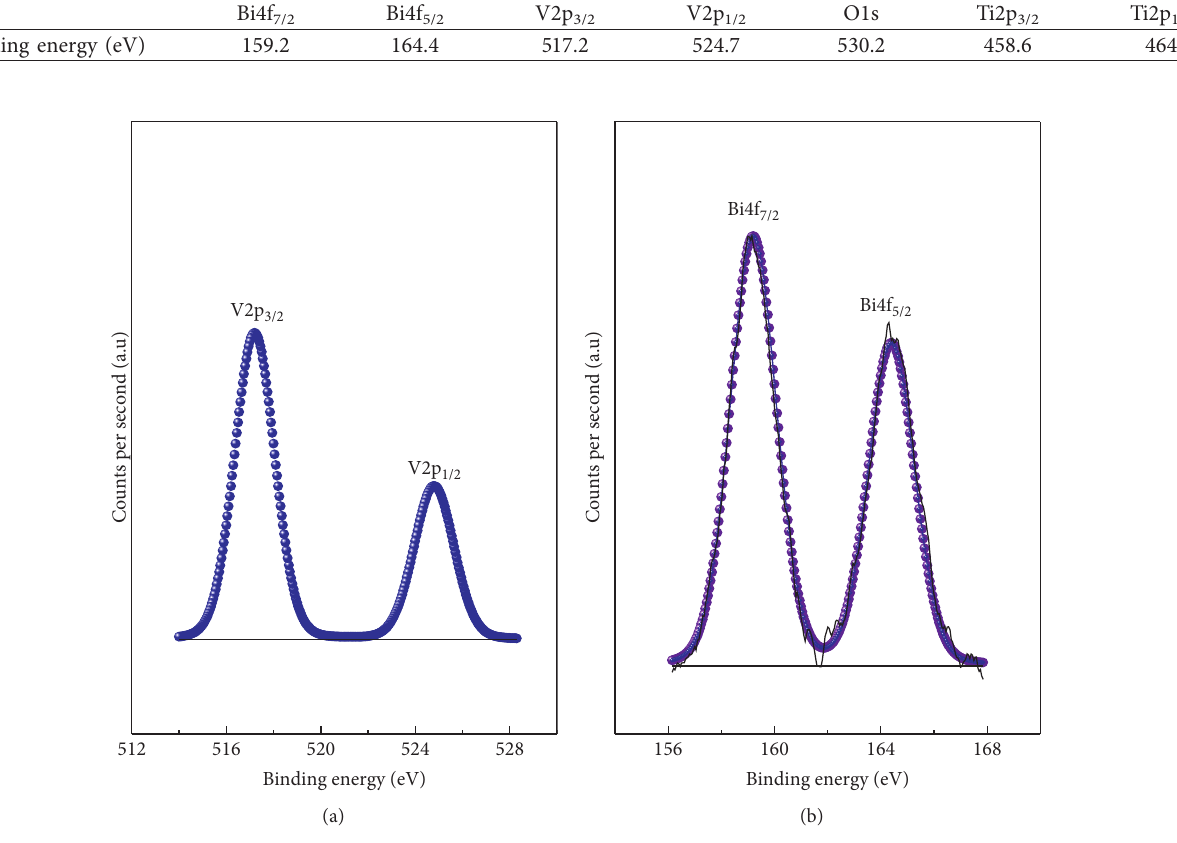
Figure 8: XPS spectra of (a) V2p and (b) Bi